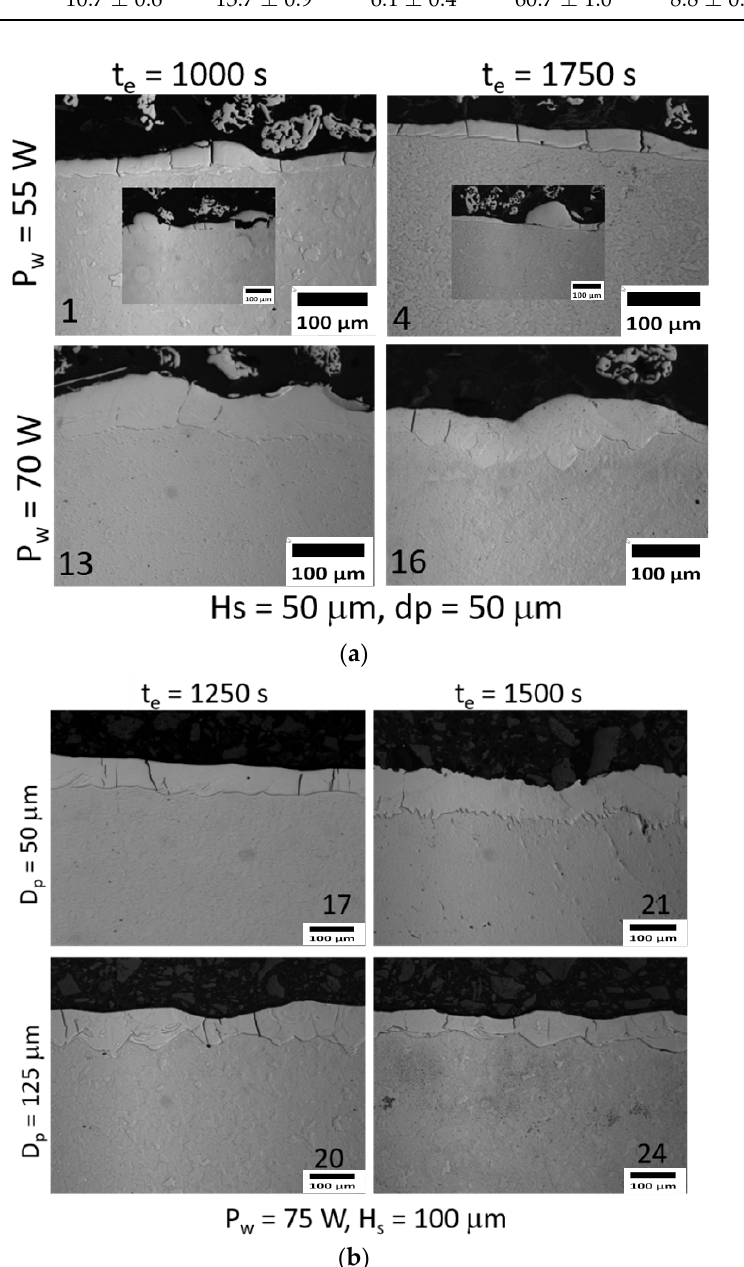
Figure 8. Images of the cross-section of coatings obtained by optical microscopy. The number ( a ) for H s = 50 µ m and d p = 50 µ m ( b ) P w = 75 W and H s = 100 µ